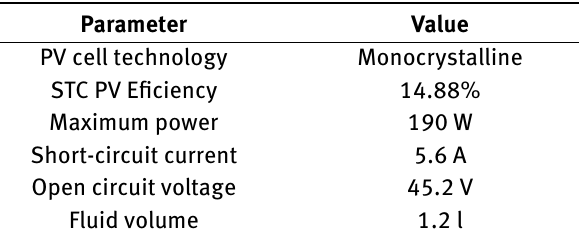
Table 1: PVT parameters (http://www.solimpeks.com/pv-t-hybrid-